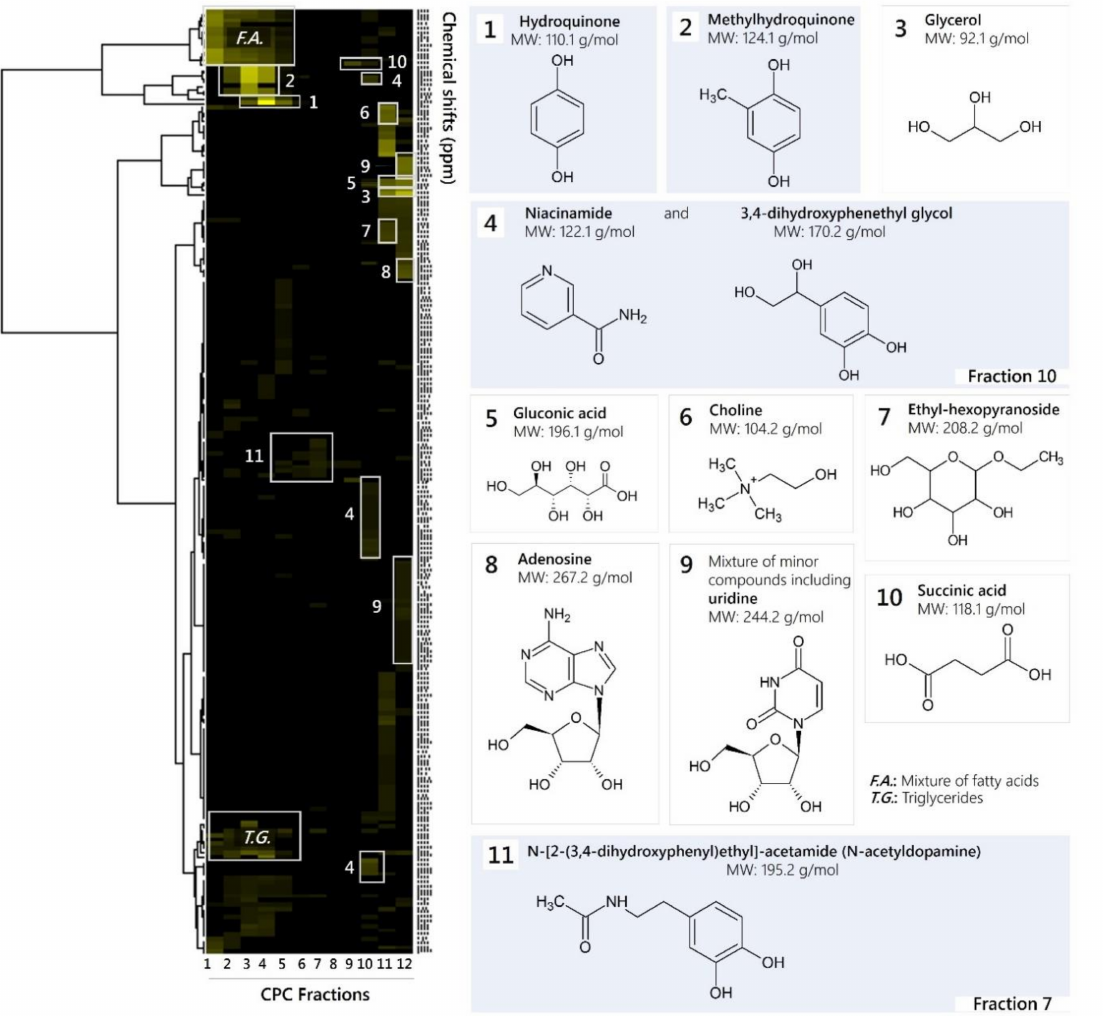
Figure 1. 13 C-NMR chemical shift clusters obtained by applying hierarchical clustering analysis on CPC fractions of an ethanolic M. bellicosus extract (soldier caste) collected from Abomey-Calavi and identified chemical structures. Fractions or pure substances that were assayed for antimicrobial activity are highlighted in